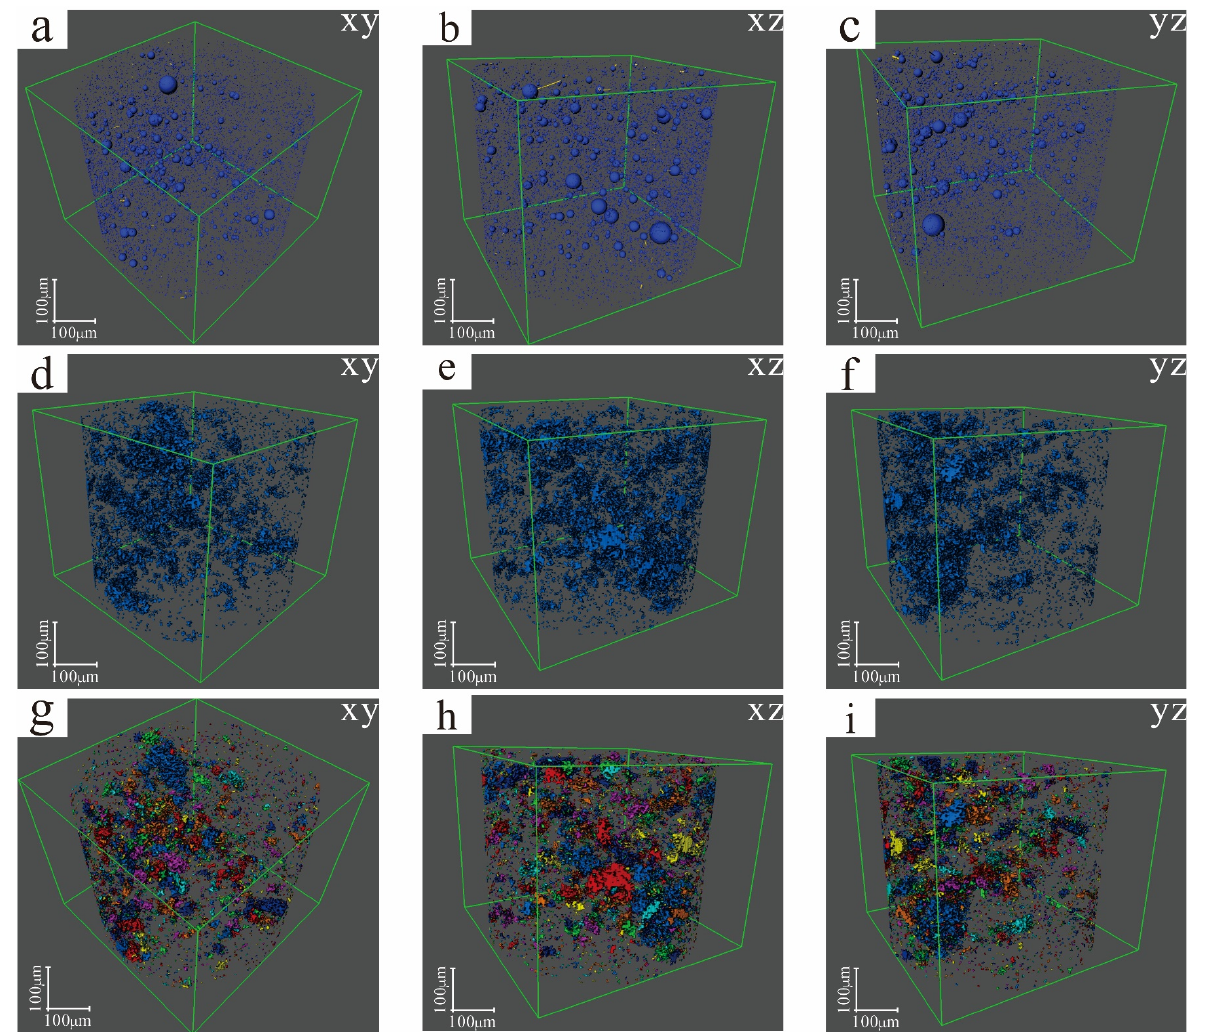
Figure 19. Pore and pore throat structure imaging of sample HZ-2: ( a – c ) the blue spheres represent the pores, and yellow lines represent the pore throats; ( d – f ) blue represents the spatial position of the pores and pore throats; ( g – i ) the pores with similar colors in adjacent regions are connected.